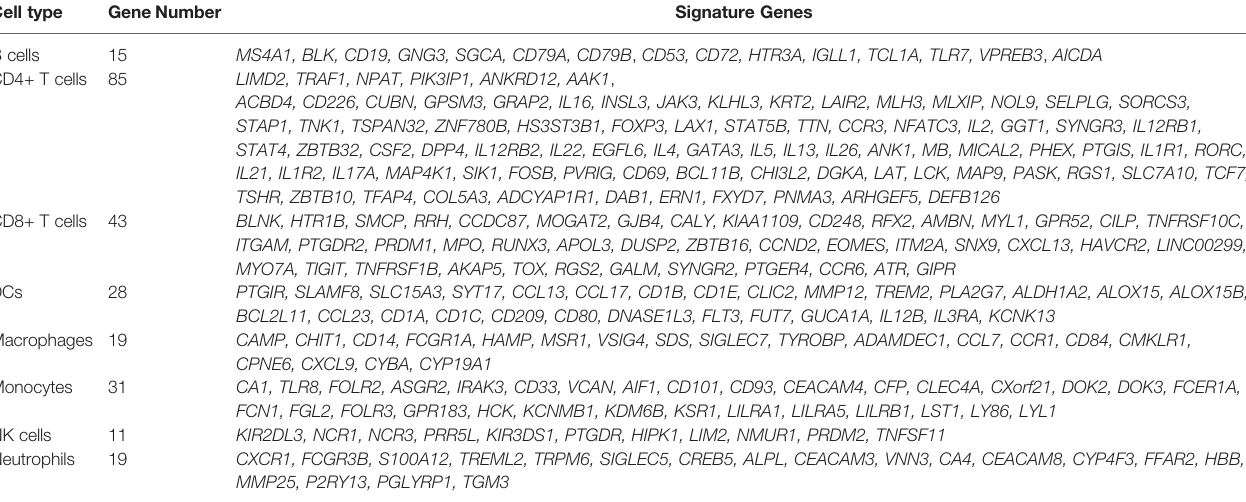
r = 0.96 and P = 4.1 × 10 − 7 for neutrophils; Figure 2A ). Then, we used scRNA-Seq data from 10 colon cancer samples (GSE146771) and compared TICPE predictions with measured